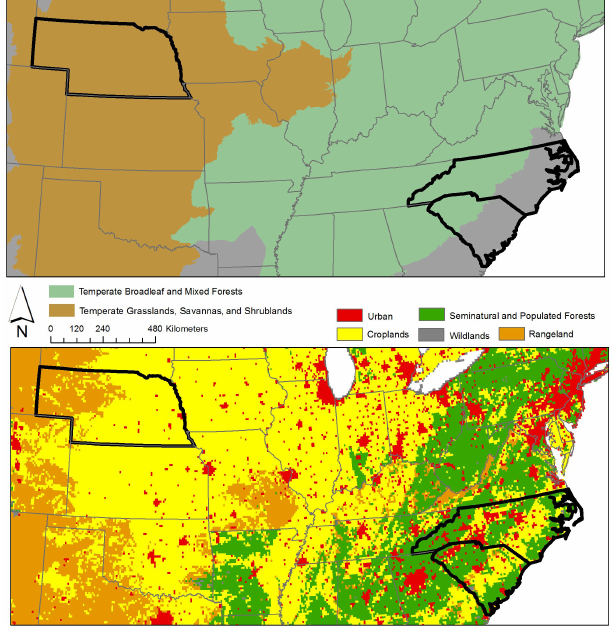
Fig. 2 . Regions represented by the two case studies (bold black boundaries) embedded in their natural biome type and current anthrome (Ellis et al.